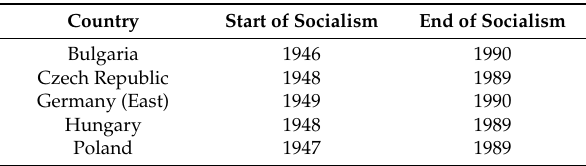
Table A2. Post-socialist Countries and the Duration of Their Socialist Era.